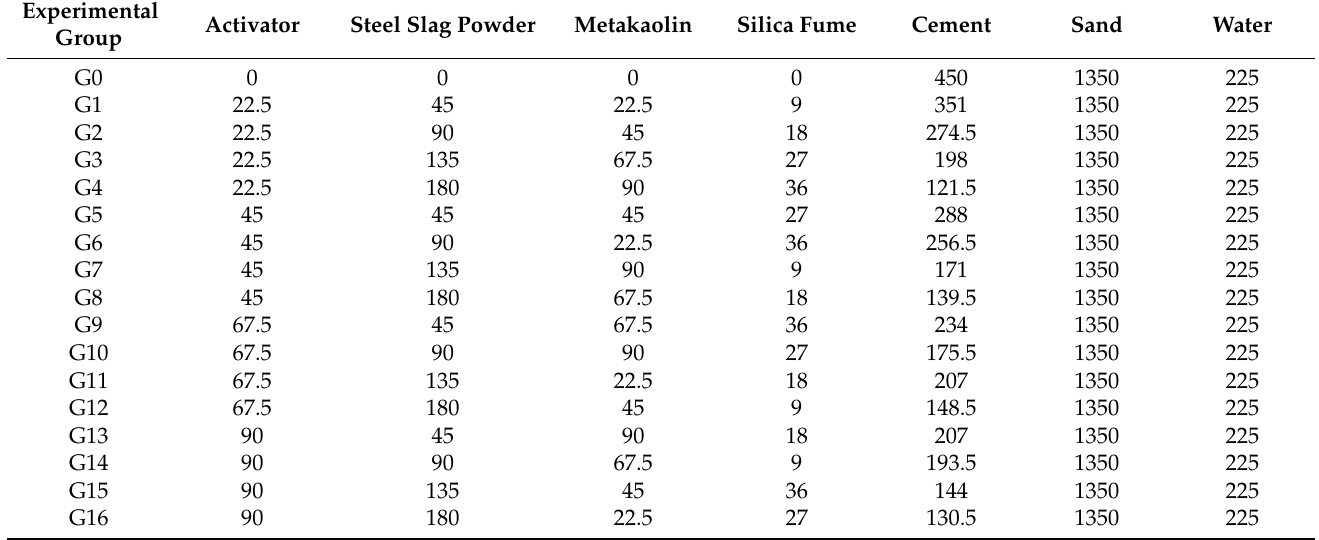
Table 4. Mix proportions